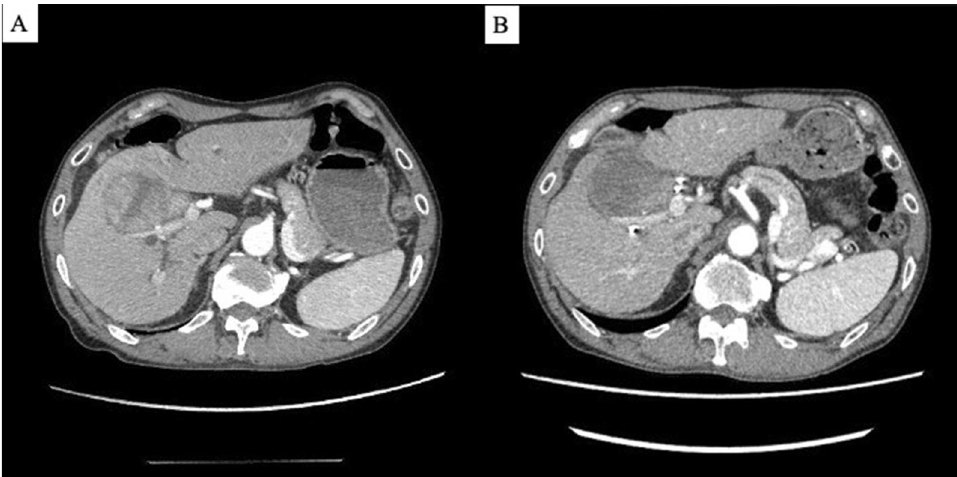
Fig. 1 Preoperative contrast-enhanced computed tomography (CT) of the arterial phase. Huge hepatocellular carcinoma located in the hepatic hilum, before ( A ) and after ( B ) atezolizumab and bevacizumab treatment. The tumor viability seemed reduced; note that the CT attenuation number is diffusely decreased in